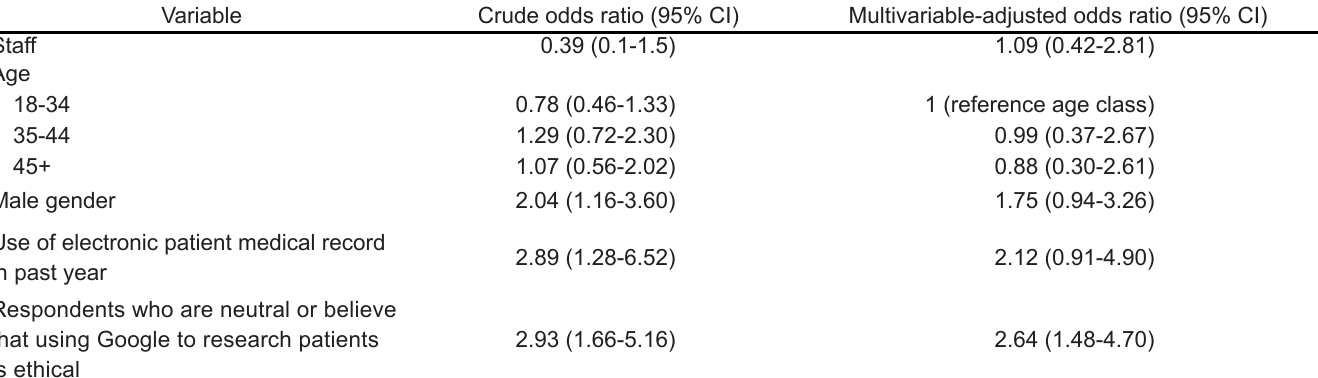
Table 4. Crude and multivariable-adjusted odds ratios of baseline variables for use of Google to research